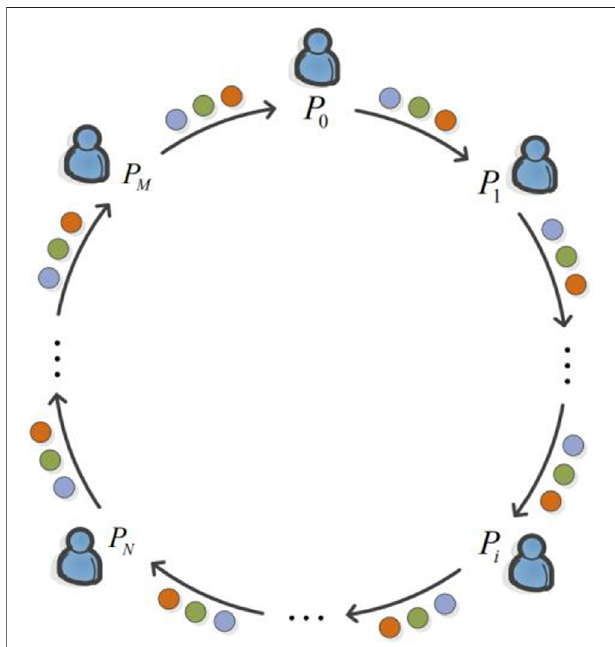
FIGURE 2 | (Color online) The detailed performance of the proposed protocol, in which different colored circles represent the particles prepared by different